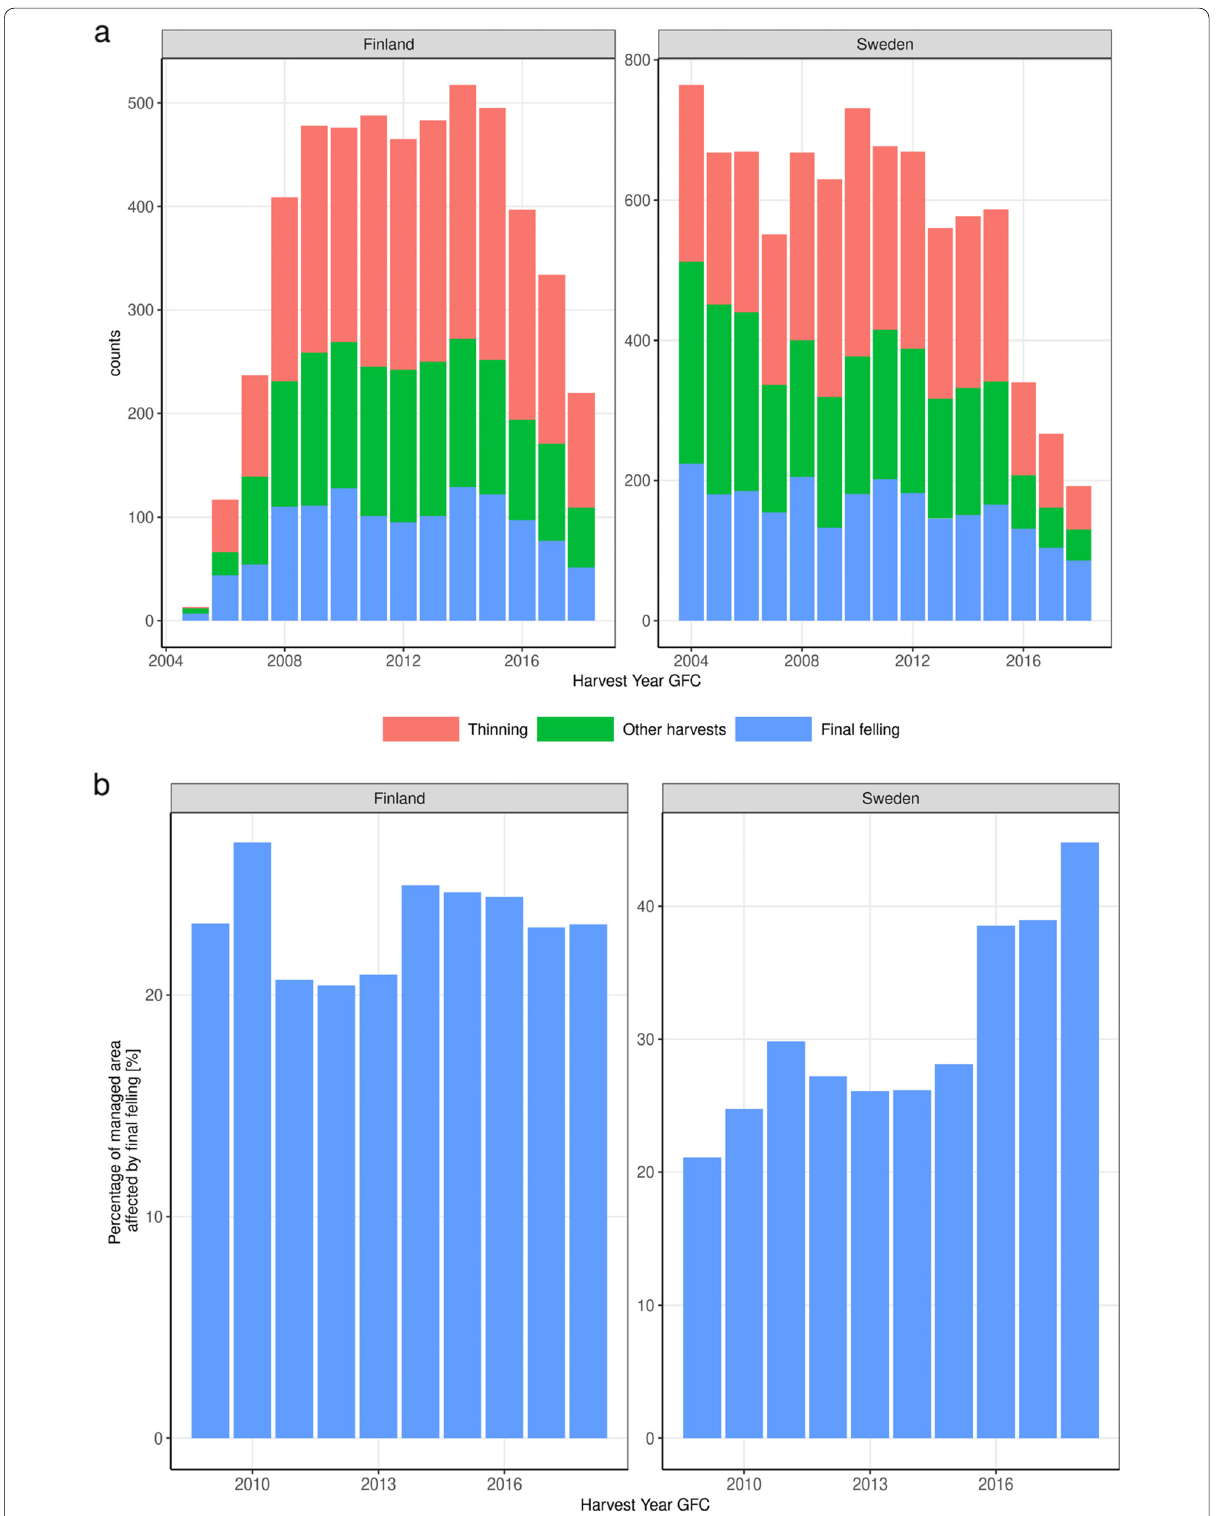
Fig. 1 Histogram of NFIs’ forest plots affected by different types of harvesting for Finland and Sweden ( a ). Note that the number of intact forest plots is equal to 10,861 and 20,725 for Finland and Sweden, respectively. Percentage of managed areas affected by final felling for Finland and Sweden ( b